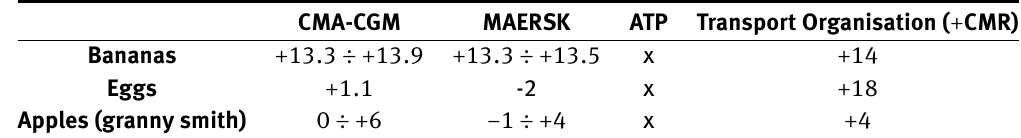
Table 1: Comparison of transport temperature (°C).